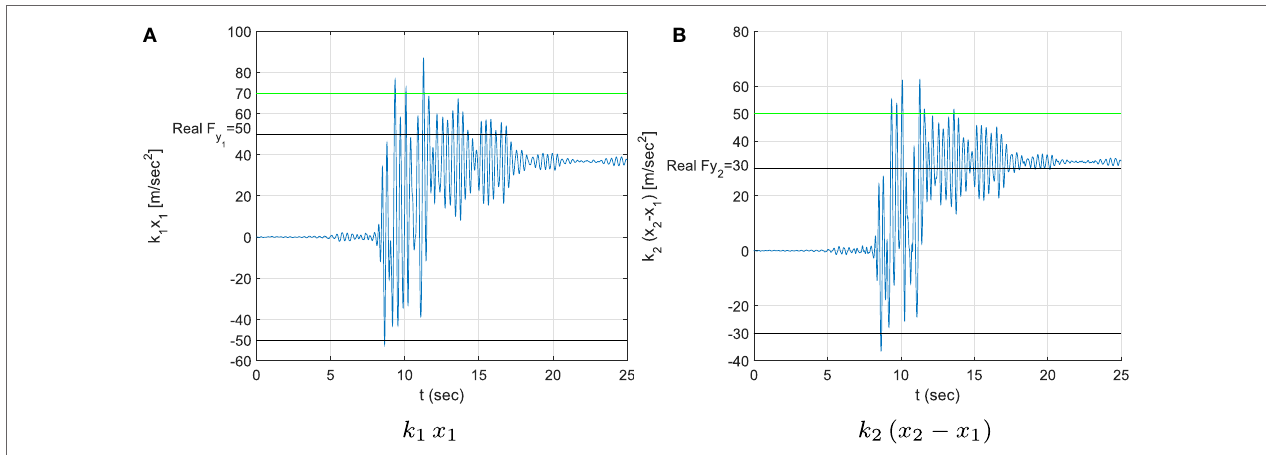
FIGURE 14 | Force displacement curves for (A) Spring 1 and (B) Spring